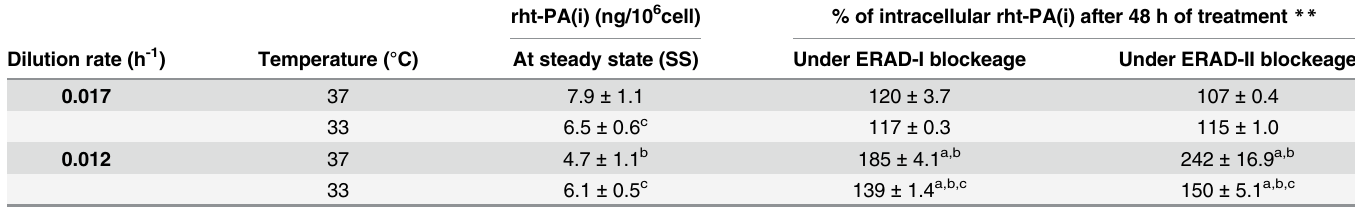
Table 2. Intracellular rht-PA accumulation at different temperatures and ERAD inhibition in the chemostat culture. rht-PA(i) (ng/10 6 cell) % of intracellular rht-PA(i) after 48 h of treatment ** Under ERAD-I